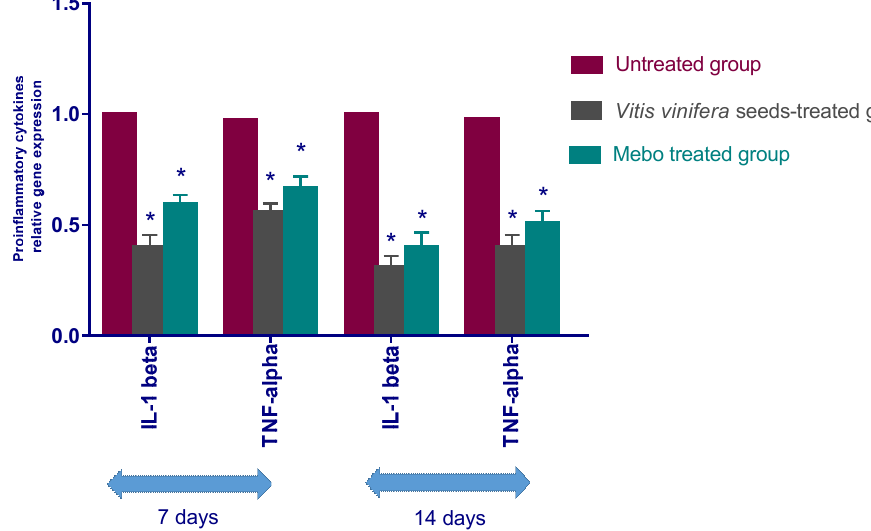
Figure 6. Relative gene expression of both IL-1 β and TNF- α in wound tissues of various groups. After making normalization to glyceraldehyde 3-phosphate dehydrogenase (GAPDH), the data indicate a fold difference in expression relative to the natural control group. The bars indicate the mean ± SD and are based on the results of three independent investigations. A one-way ANOVA test is employed to measure whether there is a significant change between groups, where: * p < 0.001 when compared to the untreated group on a specified day, and p < 0.001 when compared to the Mebo ® group on the same